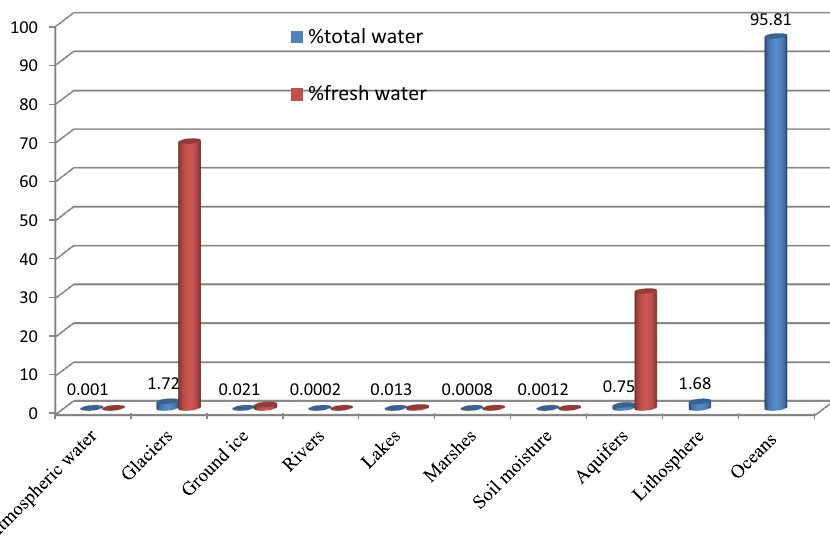
Fig. 1 Earth’s water sources and its fresh component (Data source:(El-Dessouky and Ettouney